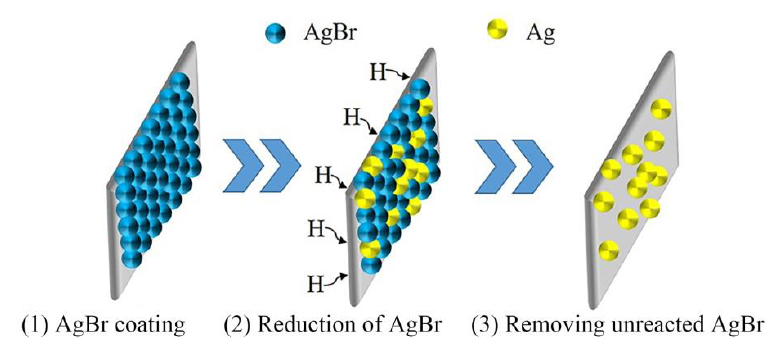
Figure 2. Schematic diagram of HMT.